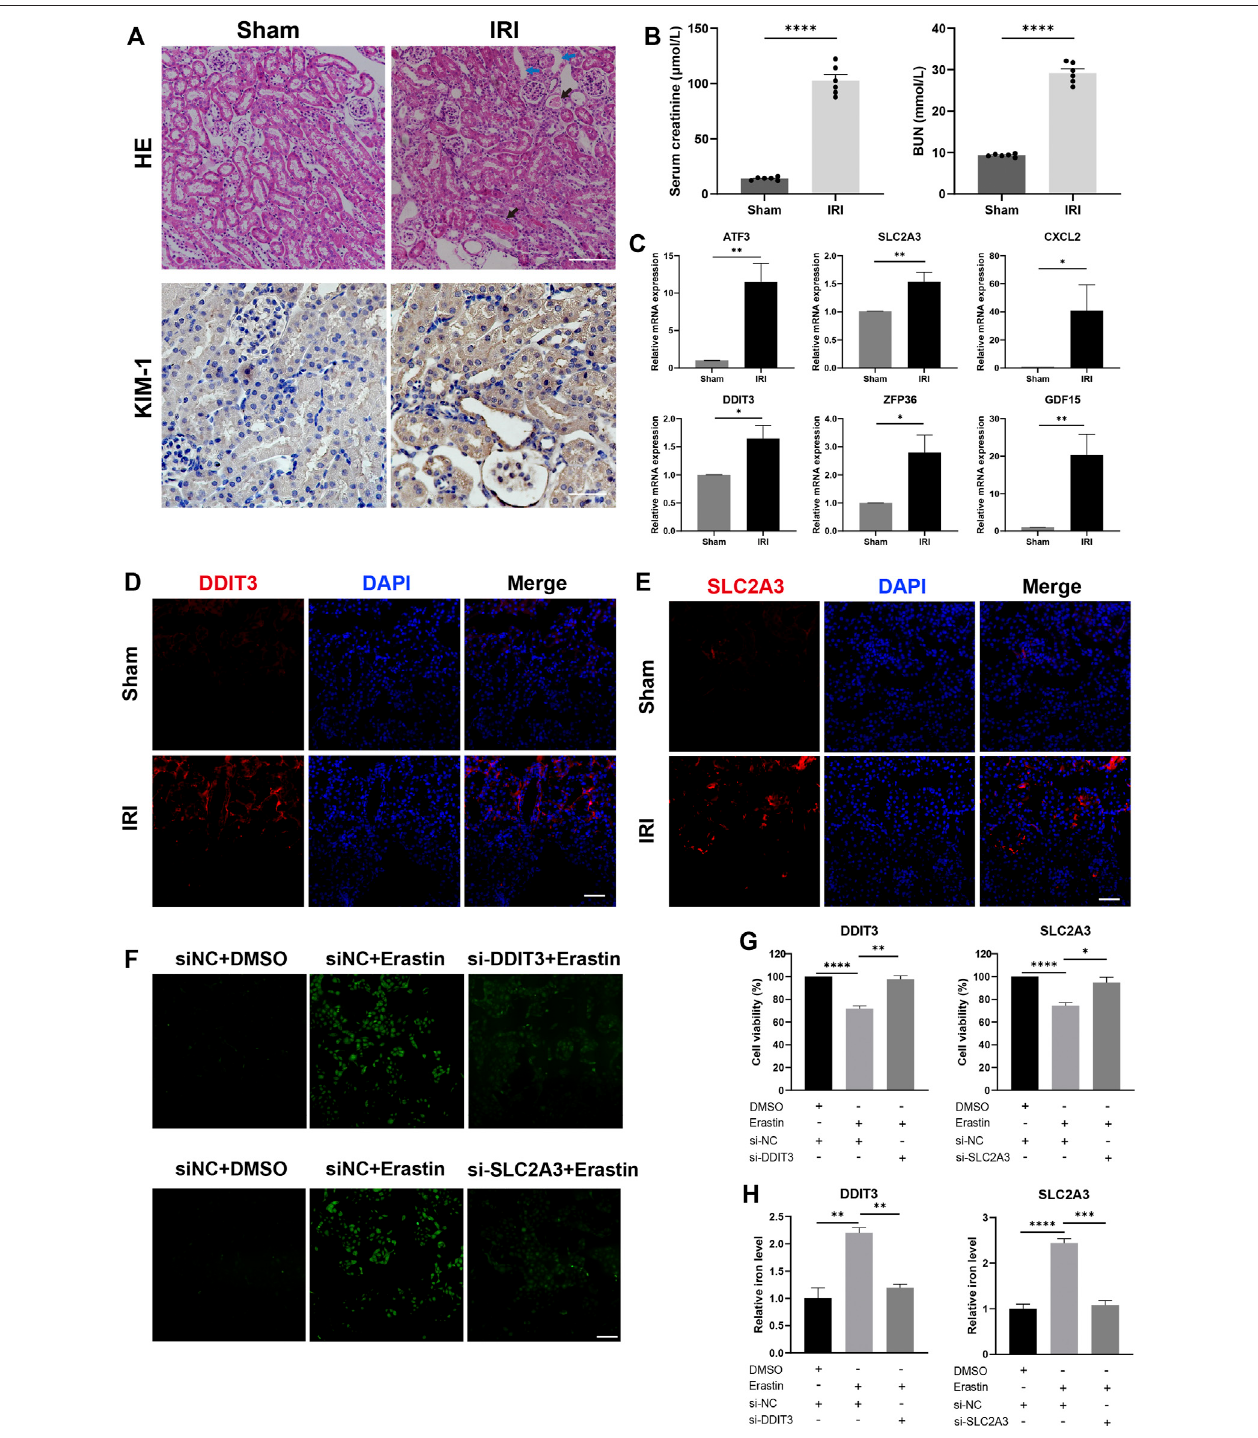
FIGURE 9 | Expression of candidate genes in the renal IRI mouse model and knockdown of DDIT3 and SLC2A3 in HK-2 cell alleviated ferroptosis. (A) Representative images of hematoxylin and eosin staining and immunohistochemistry staining of KIM-1 in IRI mice and sham mice. The image of IRI showed tubular cell death, effacement of brush border (blue arrow), and proteinaceous casts in tubules (black arrow). Scale bars, 100 μ m. n = 3 per group. (B) Serum creatinine and BUN were measured in the IRI group and the sham group. n = 6 per group. (C) mRNA expression level of ATF3, SLC2A3, CXCL2, DDIT3, ZFP36, and GDF15 in kidney tissue of the IRI group and the sham group. n = 3 per group. (D,E) Representative immuno fl uorescence images of DDIT3 and SLC2A3 in kidney tissue of IRI mice and sham mice. Nuclei were stained with DAPI (blue). Scale bars, 100 μ m. n = 3 per group. (F) ROS generation was detected using DCFH-DA staining. HK-2 cells were